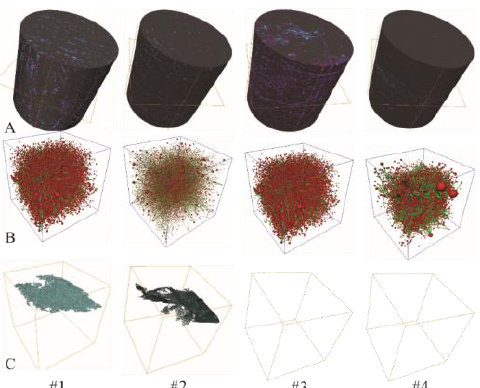
Figure 4—3D digital models, ball-and-stick models, and interconnected pore models of coal samples based on X-ray CT after CO 2